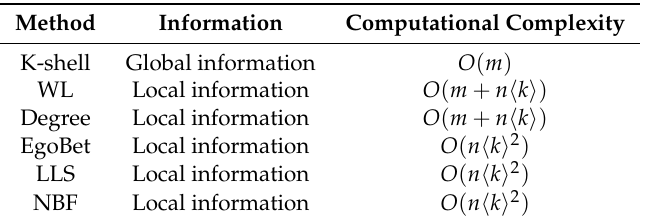
Table 2. The computational complexity of six